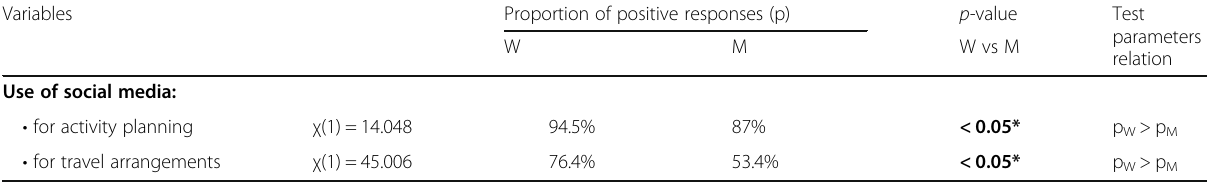
Table 4 Summary of test results for comparisons between women and men regarding social media use Variables Proportion of positive responses (p) p- value Test parameters relationW M W vs